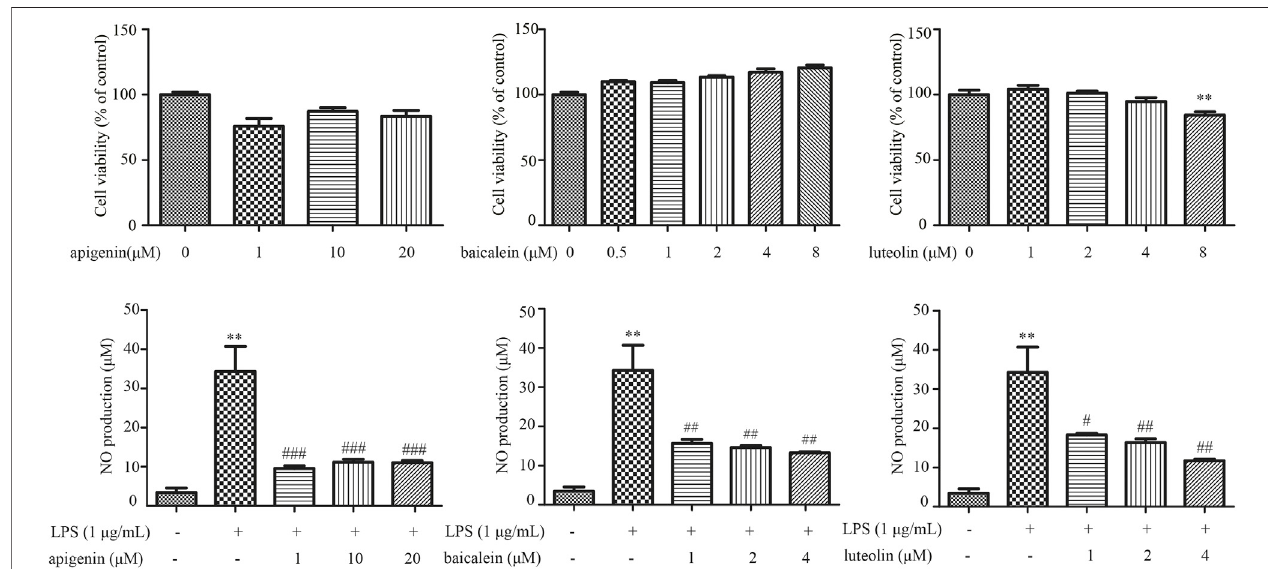
FIGURE 11 | The effects of apigenin (A,D) , baicalein (B,E) , and luteolin (C,F) on the cell viability and suppressing LPS-induced NO in RAW264.7 cells. Data are expressed as mean ± SD (n (cid:2) 3), ** p ＜ 0.01 vs control group alone, # p ＜ 0.05 vs control group alone, ## p ＜ 0.01 vs control group alone, ### p ＜ 0.001 vs control group